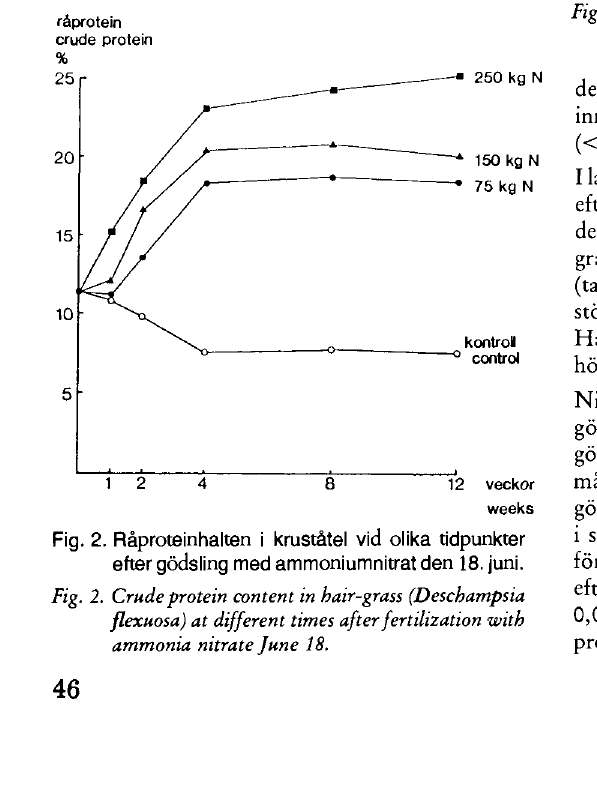
Fig. 3. Råproteinhalten i kruståtel vid olika tidpunkt efter gödsling med ammoniumnitrat den 22 juli. Fig. 3. Crude protein content in hair-grass (Deschampsia flexuosa) at different times after fertilization with ammonia nitrate July